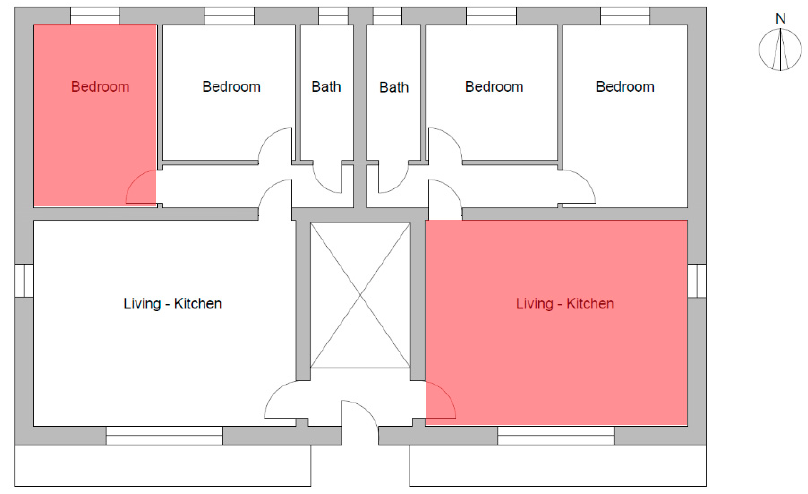
Figure 6. Representative rooms for adaptive comfort assessment: southeast living room and northwest double bedroom.